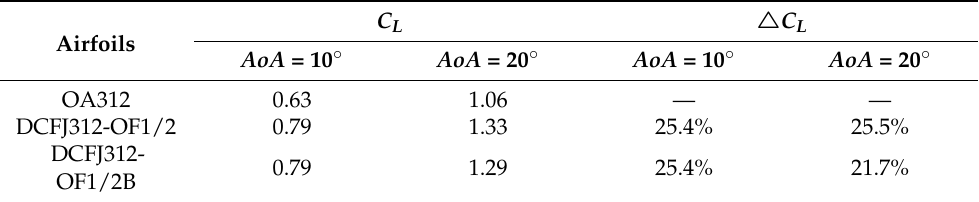
Table 13. Comparisons of drag coefficients and lift-to-drag ratios of DCFJ312 airfoils with various RUL s at AoA = 20°.